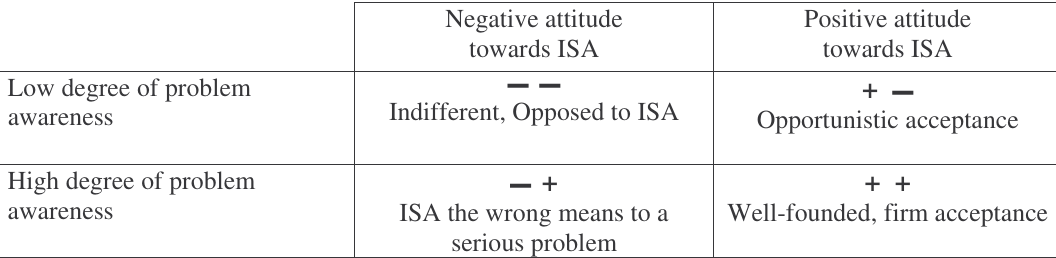
Table 2. Reference groups and exposure to ISA